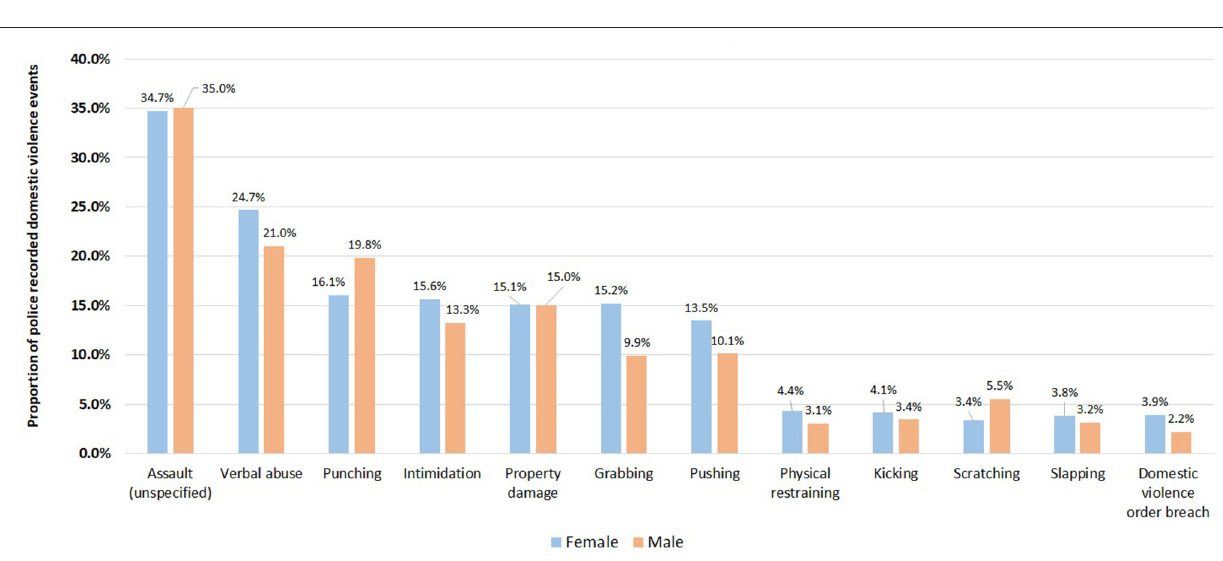
FIGURE 6 | Comparison of proportions of abuse types (top 10 only) for male and female victims in 416,441 police recorded domestic violence events in NSW, January 2005–December